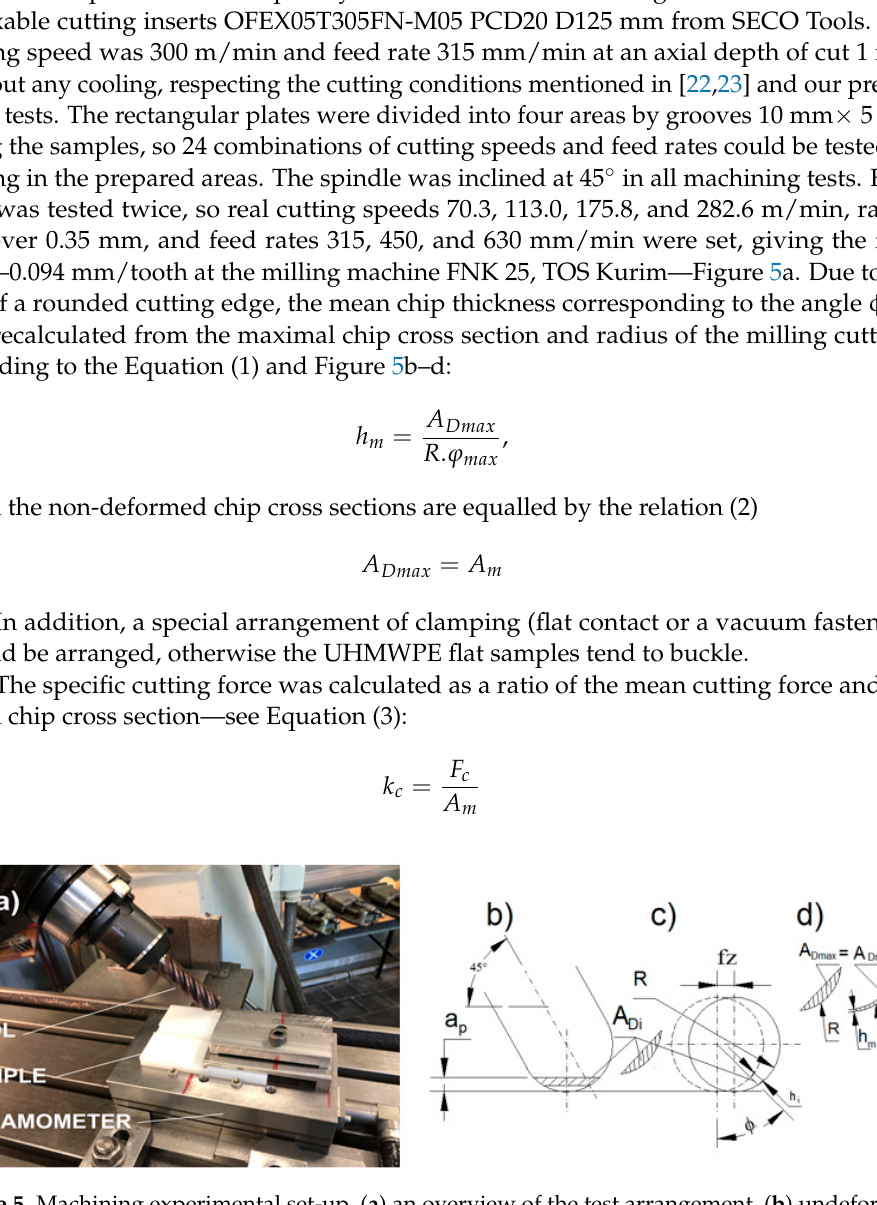
Figure 5. Machining experimental set ‐ up, ( a ) an overview of the test arrangement, ( b ) undeformed chip cross ‐ section A D i, ( c ) stepover when milling for feed per tooth f z , ( d ) a recalculation of the variable chip thickness h i along the cutting edge to the nominal mean value of chip thickness h m .